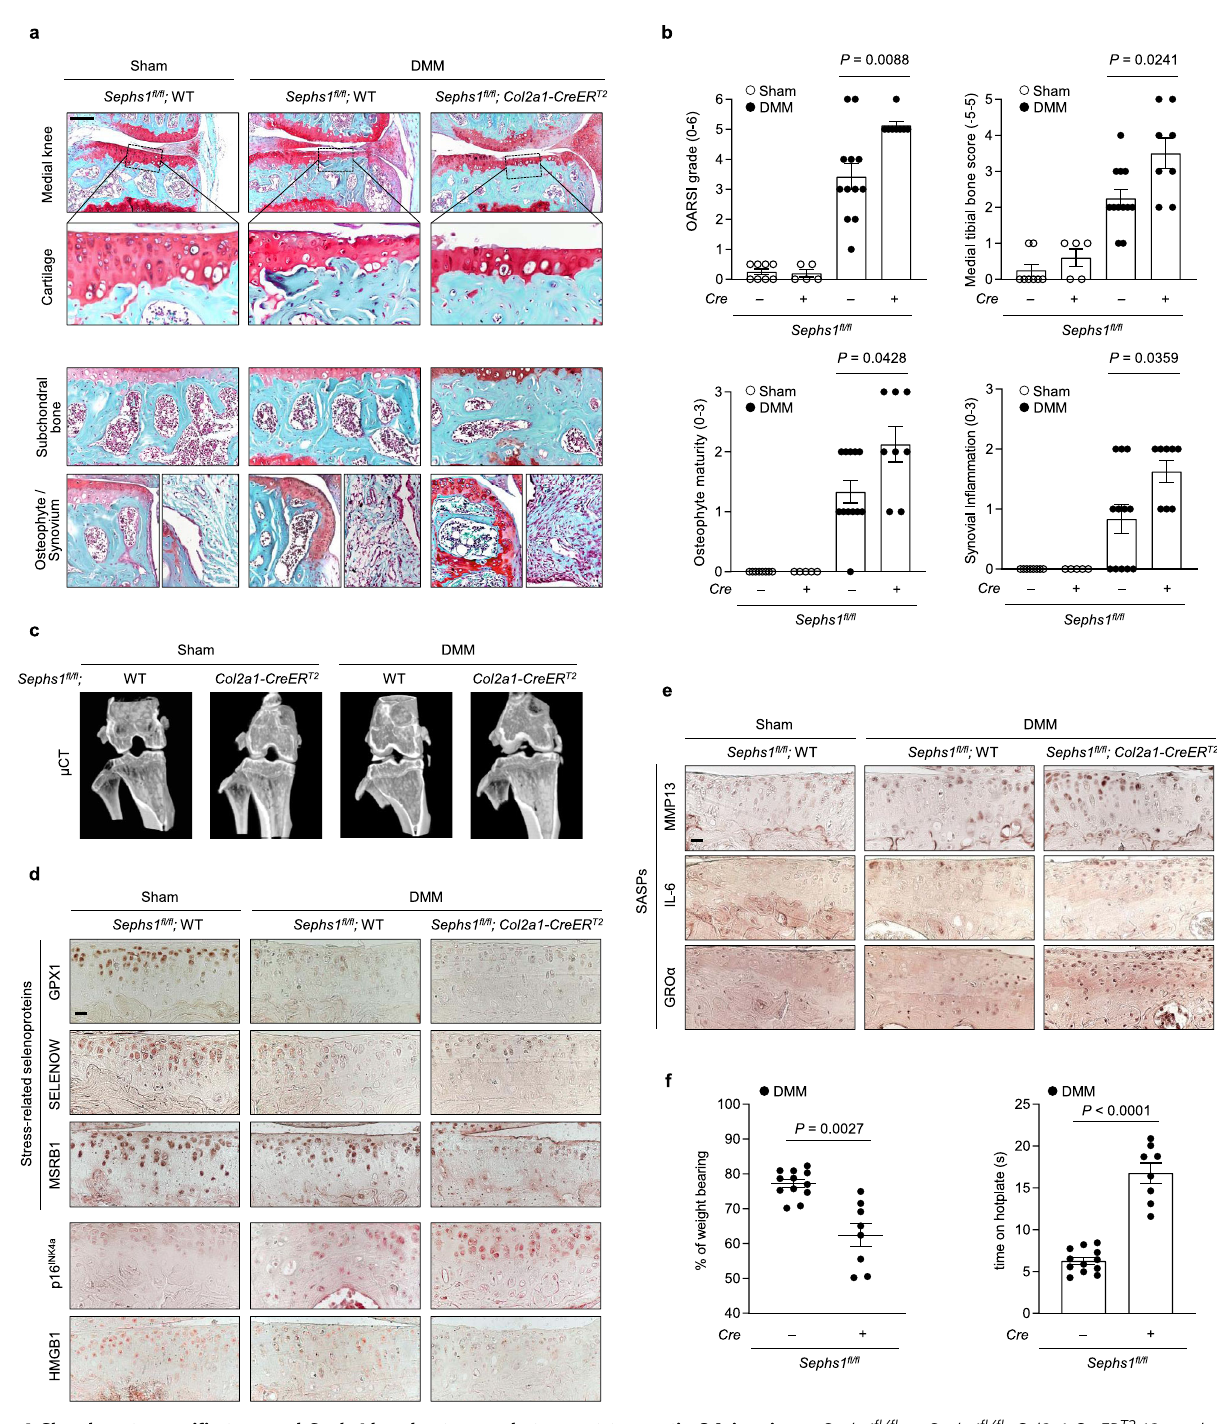
Fig. 4 Chondrocyte-speci fi c temporal Sephs1 knockout exacerbates post-traumatic OA in mice. a Sephs1 fl / fl or Sephs1 fl / fl ; Col2a1-CreER T2 12-week-old mice were injected with TMX fi ve times and subjected to sham operation or DMM surgery. Joint sections were stained with safranin O, fast green, and hematoxylin. The inset in the images is shown as magni fi ed images in the bottom row. b Cartilage destruction, subchondral bone sclerosis, osteophyte formation, and synovial in fl ammation determined by safranin O/hematoxylin staining and scored ( n = 8 for sham-operated WT; n = 5 for sham-operated Sephs1 -iCKO; n = 12 for DMM-operated WT; n = 8 for DMM-operated Sephs1 -iCKO). c Representative microcomputed tomography ( μ CT) images of sham- or DMM-operated WT and Sephs1 -iCKO mice. d Stress-related selenoproteins (GPX1, SELENOW, and MSRB1), p16 INK4a , HMGB1, and e SASPs (MMP13, IL-6, and GRO α ) were detected by immunohistochemistry in cartilage sections. f Hotplate pain assays in DMM-operated WT and Sephs1 -iCKO mice (left panel, n = 12 for WT; n = 8 for Sephs1 -iCKO). The percentage of weight placed on the sham- or DMM-operated limb versus the contralateral limb of WT and Sephs1 -iCKO mice (right panel, n = 12 for WT; n = 8 for Sephs1 -iCKO). Scale bars: a 200 μ m, d , e 25 μ m. b , f Data represent means ± s.e.m. P values are from Kruskal – Wallis test followed by Mann – Whitney U test ( b ) or two-tailed t test ( f ). Cohen ’ s d effect sizes are provided in Supplementary Table 8. Mankin scores and SBP thickness measurements are provided in Supplementary Figs. 11 and